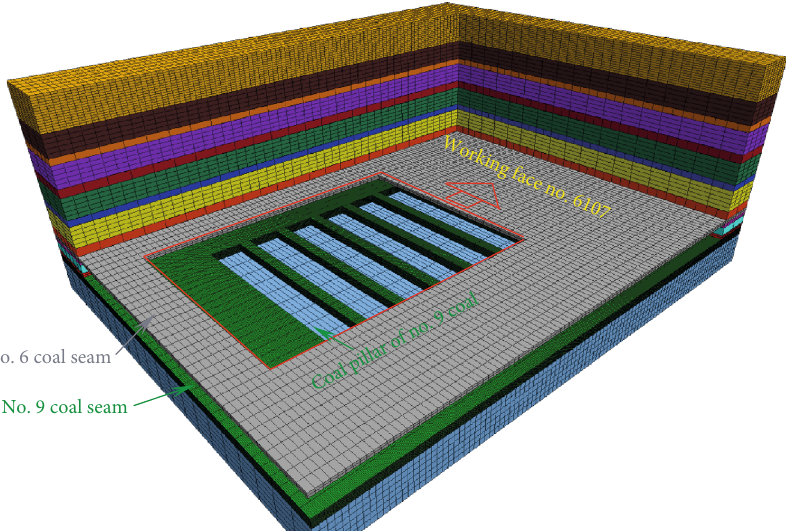
Figure 4: Schematic diagram of no. 6107 working face mining above the room-and-pillar goaf.